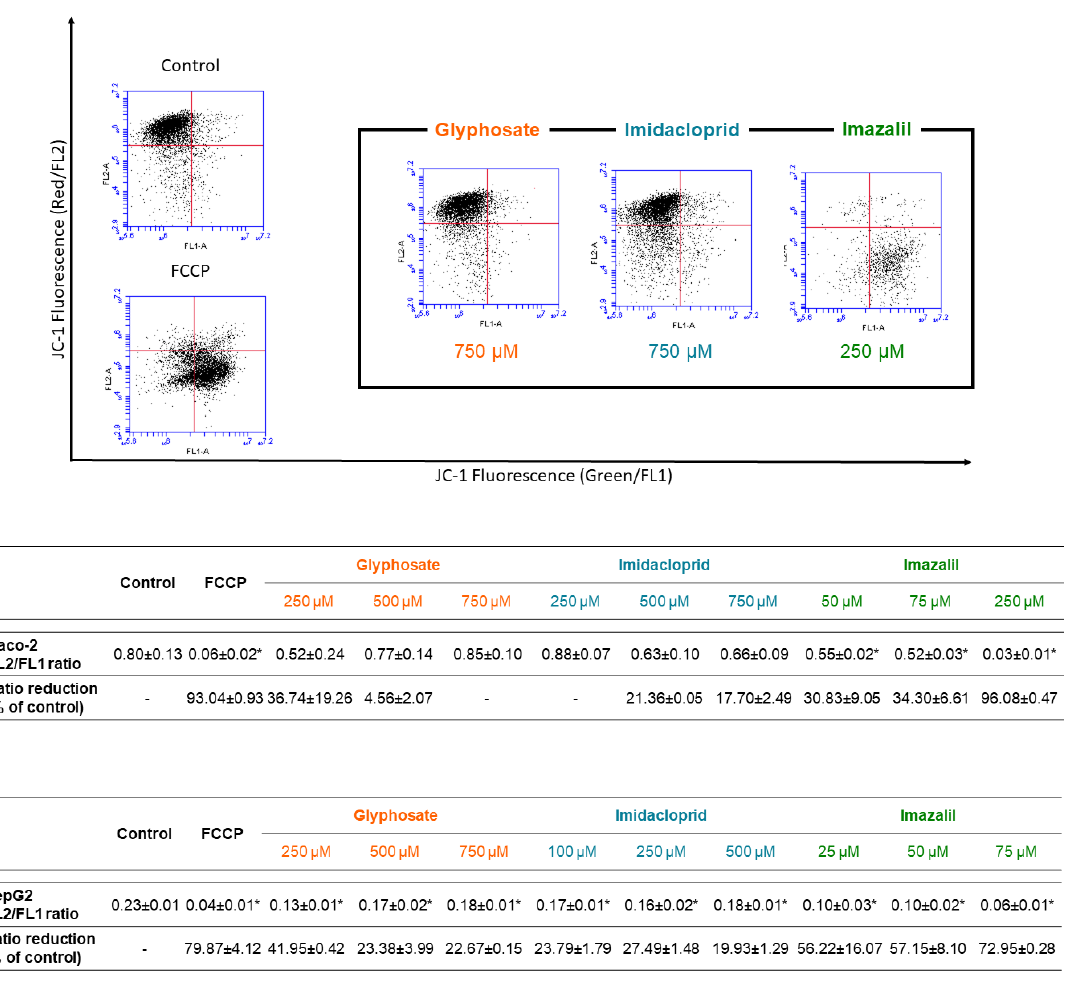
Figure 5. Assessment of changes on mitochondrial membrane potential (MMP) in Caco-2 ( A , B ) and HepG2 ( C , D ) cells exposed to GLY, IMD, and IMZ for 24 h, at indicated concentrations. Flow cy- tometry dot plots of Caco-2 ( A ) and HepG2 ( D ) cells exposed to the highest concentrations of each pesticide. The calculated FL2/FL1 ratio for Caco-2 ( B ) and HepG2 ( C ) cells exposed to 3 different concentrations of each pesticide, and the percentage of FL2/FL1 rate decay comparing to respective control. Results are presented as mean ± SD. Significant statistical differences between the control and samples are denoted as “*” when p < 0.05. 2.4. Evaluation of Pesticide-Induced Apoptosis/Necrosis Due to the loss in cell viability and to the increase in oxidative stress as accompanied by the loss in MMP, which are signs of apoptosis induction, we further analysed the effect